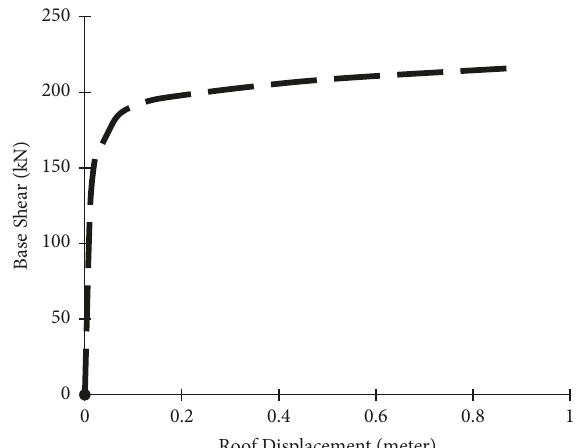
Figure 16: Steel-HSS braced portal frame pushover